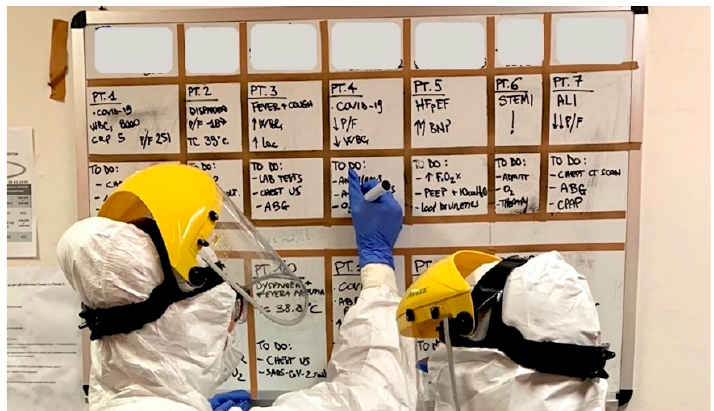
Figure 2. Whiteboard visual check.